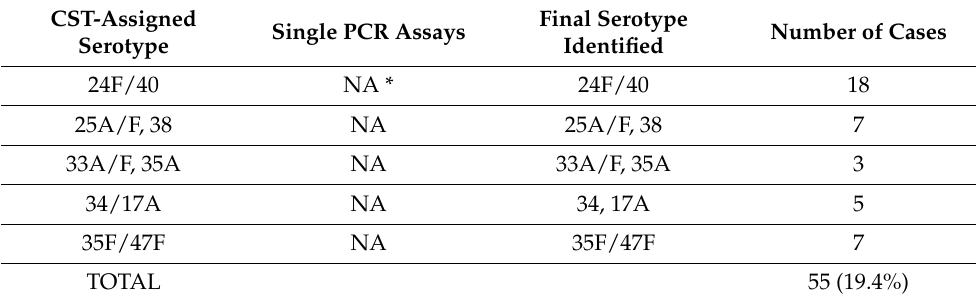
Table 5. Pneumococcal serotype identification by the application of CST assigning two or two